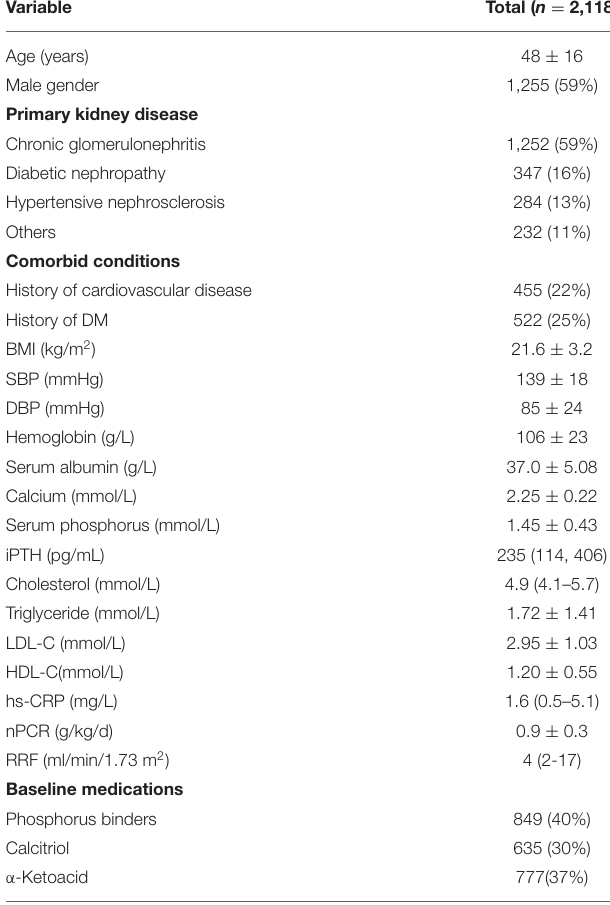
TABLE 1 | Baseline characteristics of study cohort.